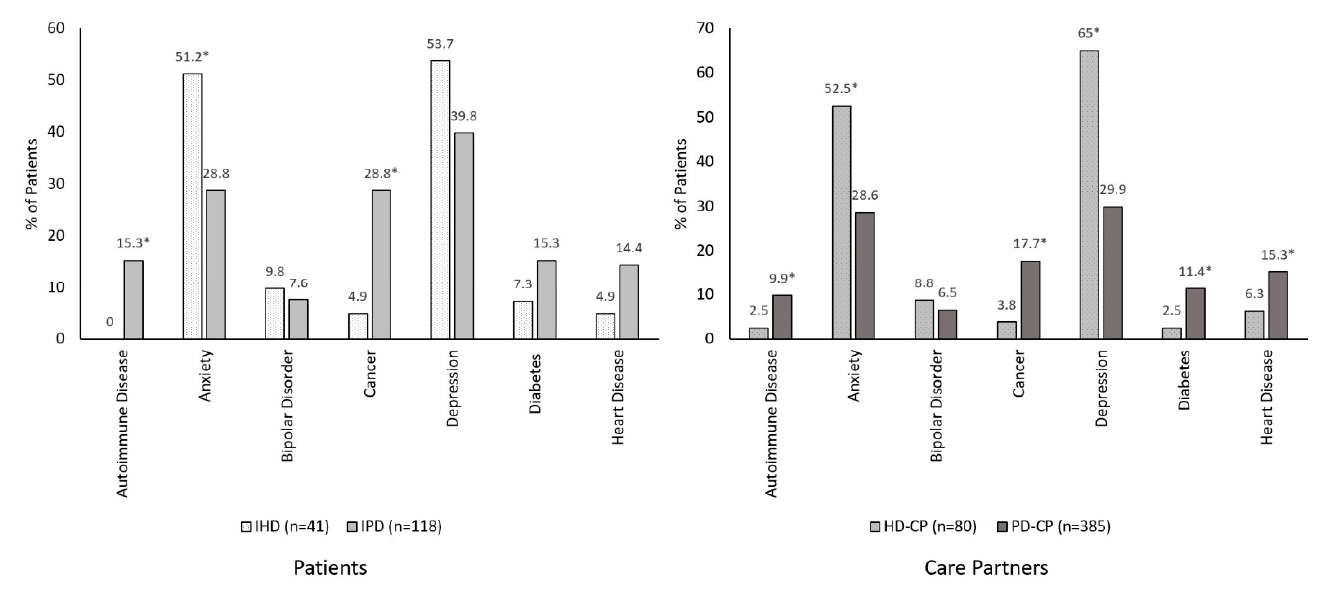
Figure 6. Comorbidities among HD relative to PD. IHD vs. IPD comparisons adjusted for sex using multivariable regression; HD-CP vs. PD-CP comparisons adjusted for sex and age using multivariable regression. * p < 0.05. CP, care partner; IHD, individuals with Huntington’s disease; IPD, individuals with Parkinson’s disease.